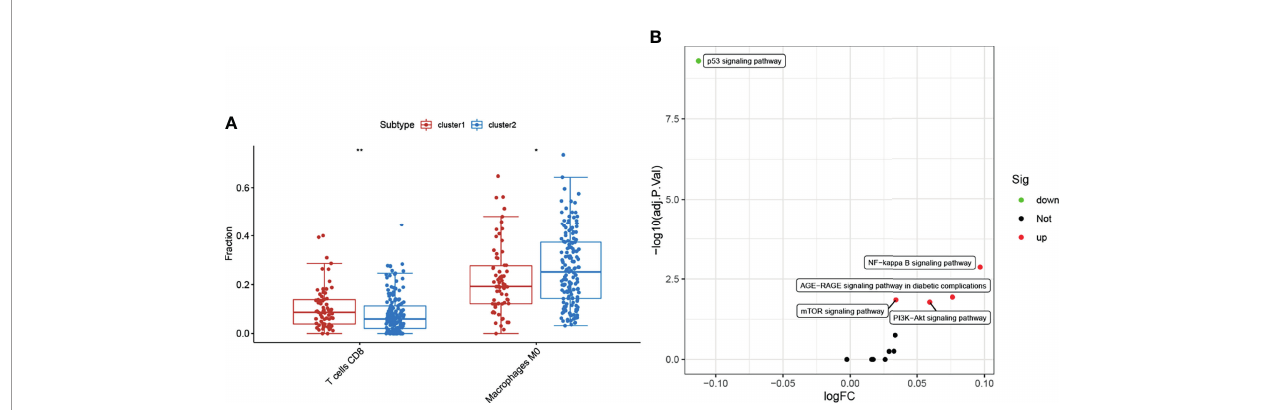
FIGURE 8 | Evaluation of immune cell and hypoxia signaling pathways. (A) Compared with the cluster2 group, the cluster1 group had upregulated CD8 T lymphocytes, whereas M0 macrophages were downregulated (* p < 0.05, ** p < 0.01). (B) Changes in cluster1 and cluster2 hypoxia signaling pathways were not signi fi cant (FDR <0.05 was considered statistically signi fi cant, but the maximum absolute value of logFC was <0.2).